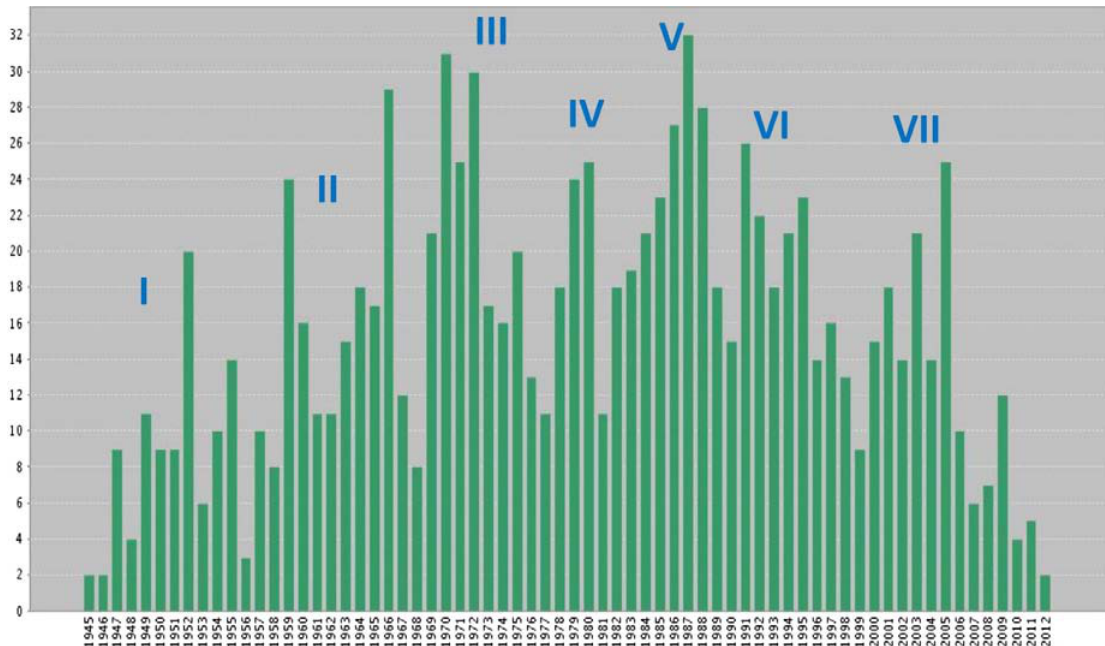
Fig. 1. The annual number of publications of Britton Chance from 1945 – 2012. Graph reproduced from ISI Citation Indexes (accessed in April, 2013 excluding meeting abstracts) with modi¯cations. There were seven periods I – VII as described in the